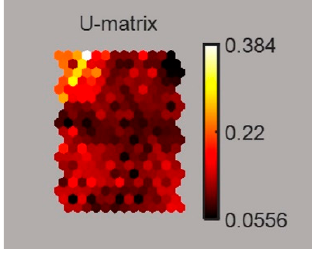
Figure 13. SOM UMatrix Map.